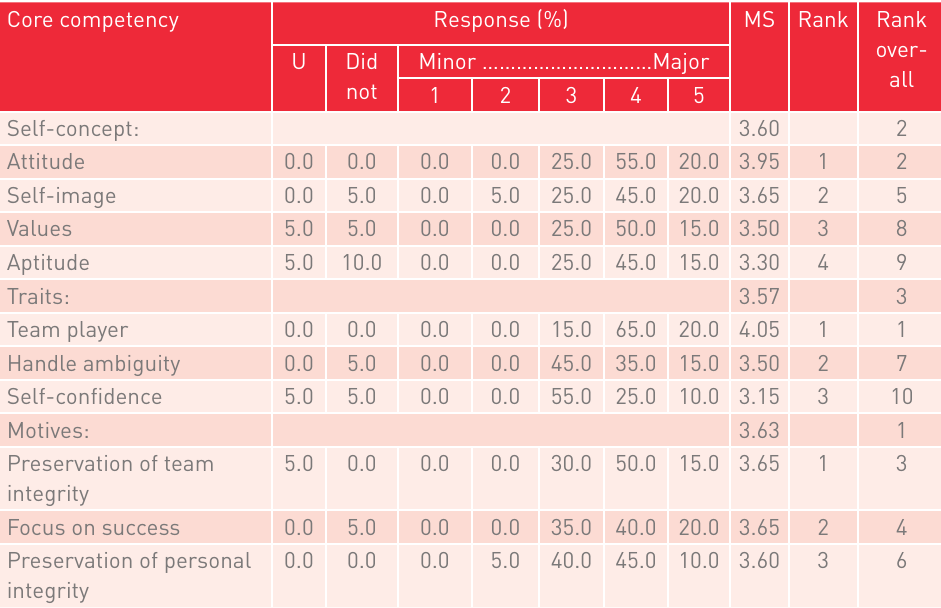
Extent to which the team building activities contributed to the development of participants’ core competencies.